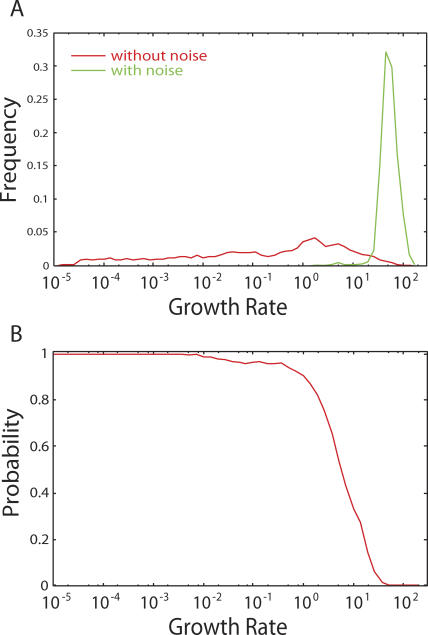
Distribution of Growth Rate and Escape Probability from an Attractor(A) The distribution of growth rate. Starting from randomly chosen 105 initial conditions, the distribution of growth rates after 105 time steps are computed with and without noise (σ = 0.2).(B) Relationship between the growth rate vg and the probability to escape an attractor within a certain period of time. The probability is computed by 105 trials starting from randomly chosen initial conditions. After a cell reaches a stable state, noise (σ = 0.2) is added, and the time it takes the cell to escape from the corresponding attractor is measured. The y-axis represents the probability that the cellular state is kicked out of the original state within 103 time steps, and the horizontal axis shows the growth rate vg of the original state.